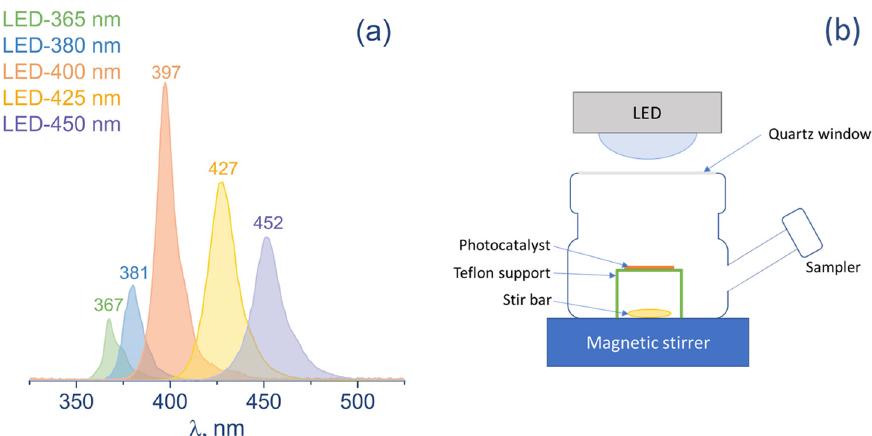
Figure 1. ( a ) Spectra of LEDs with the wavelength at maximum intensity; ( b ) scheme of reactor for photocatalytic study.